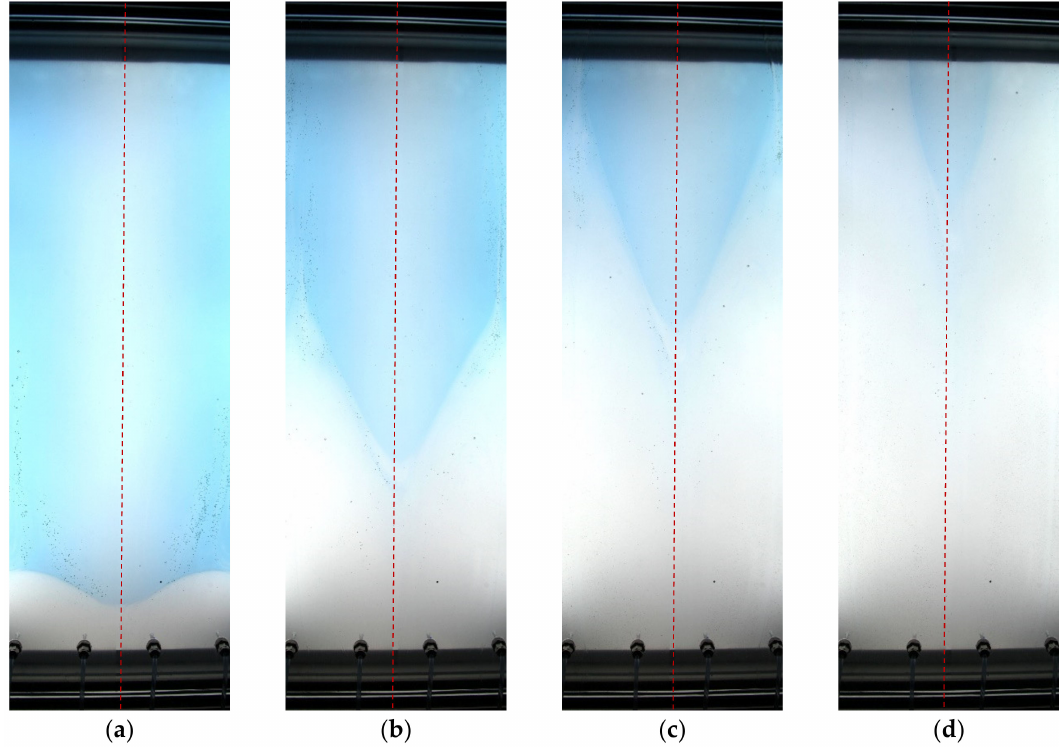
Figure 13. Snapshots of displacement flow in test no. 8. ( a ) t = 0 s; ( b ) t = 4 s; ( c ) t = 7 s; ( d ) t = 10